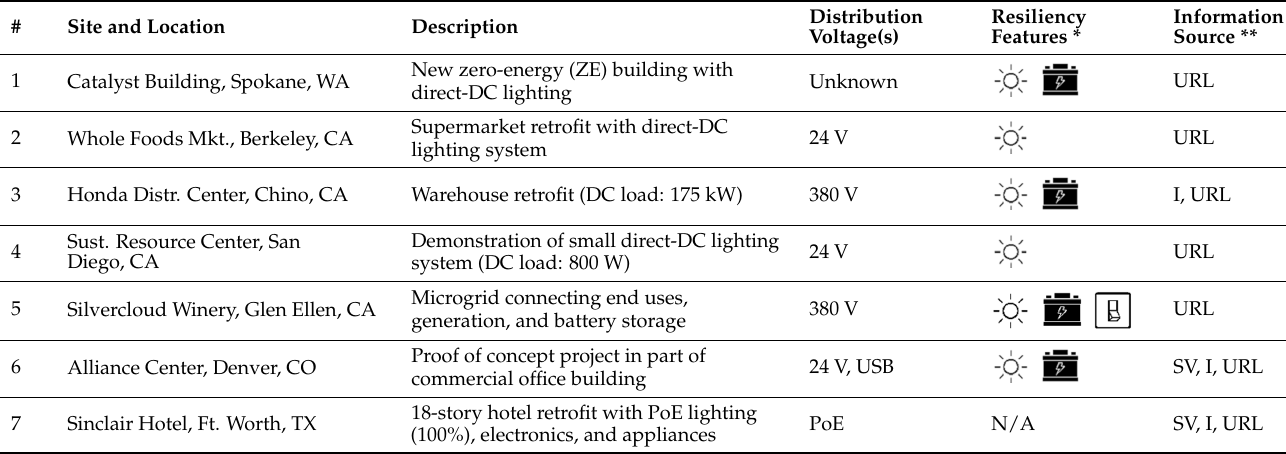
Figure 1. Map of DC distribution deployments in the United States and Canada. Note: Sites denoted with (-) are defunct/decommissioned; sites with (+) are in progress or the planning stage. Source: Lawrence Berkeley National Laboratory (map icons: thenounproject.com). Table 2. Information on DC field deployments in the United States and Canada.